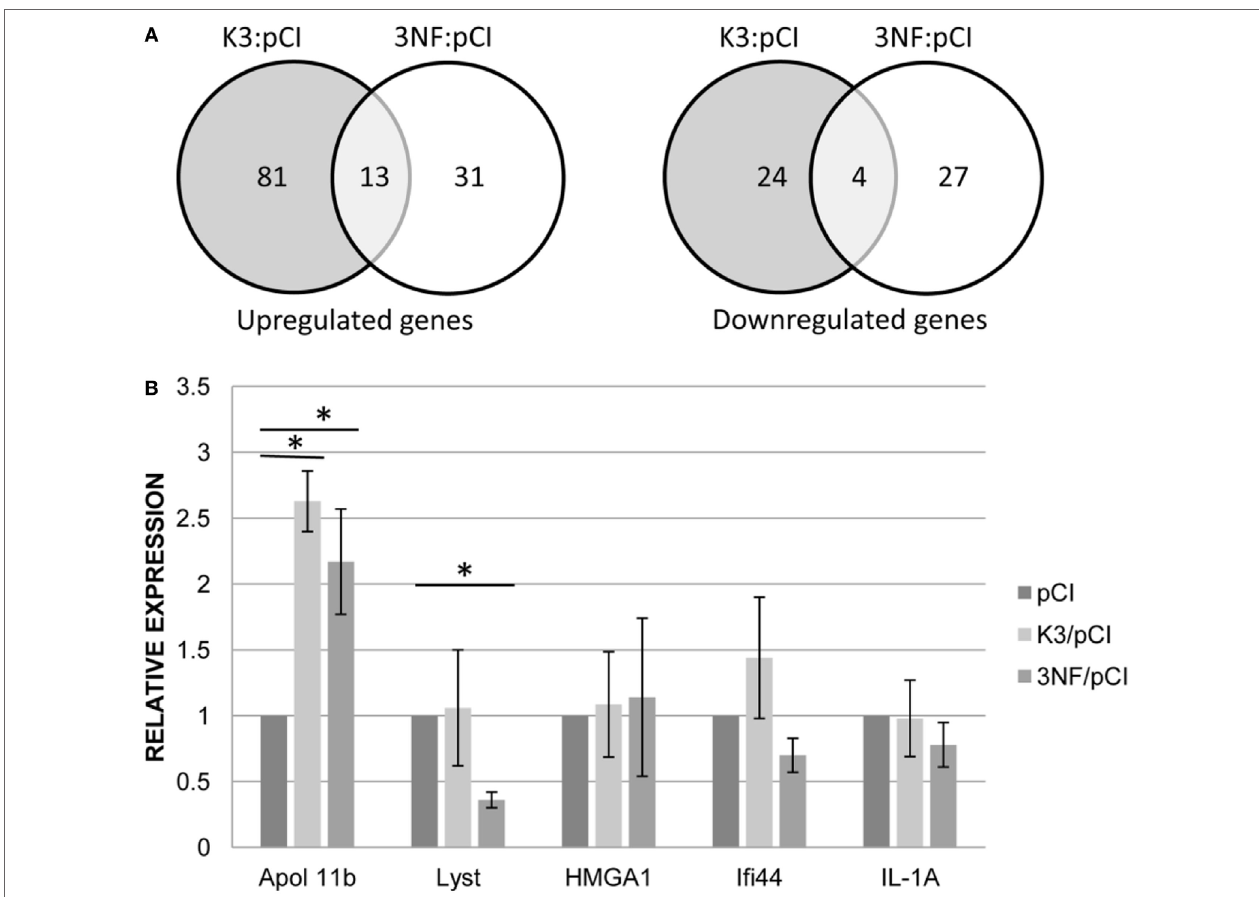
FigUre 3 | Transcriptomic changes in the spleens of mice immunized with K3/pCI and 3NF/pCI in comparison to the group that received the empty vector (pCI). (a) Venn diagrams of upregulated and downregulated genes. (B) Results of RT-qPCR for selected genes. The significant changes of the expression ( p < 0.05) in comparison to pCI group are indicated by the asterisks. Data are presented as mean values of three technical repeats for each sample with SD, calculated for all mice in a group (two mice in the control group and three mice in each experimental group were